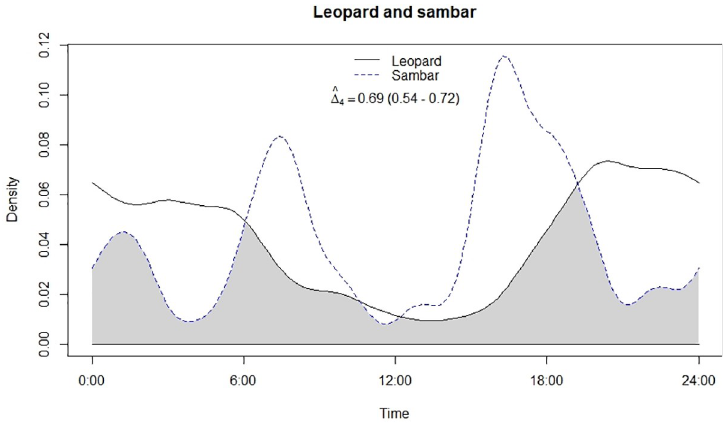
Fig 3. Temporal overlap between leopard and sambar.